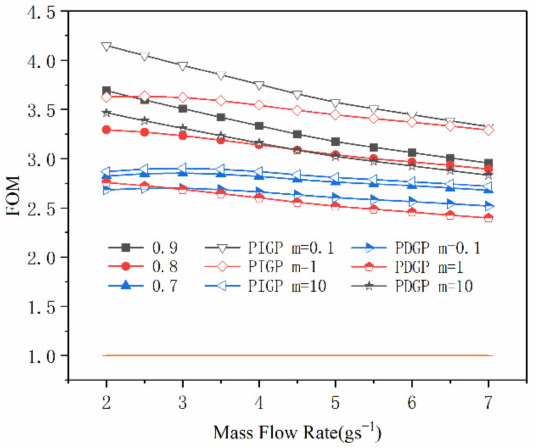
Figure 19. FOM with AFHS with gradient porosity designed in the X -axis